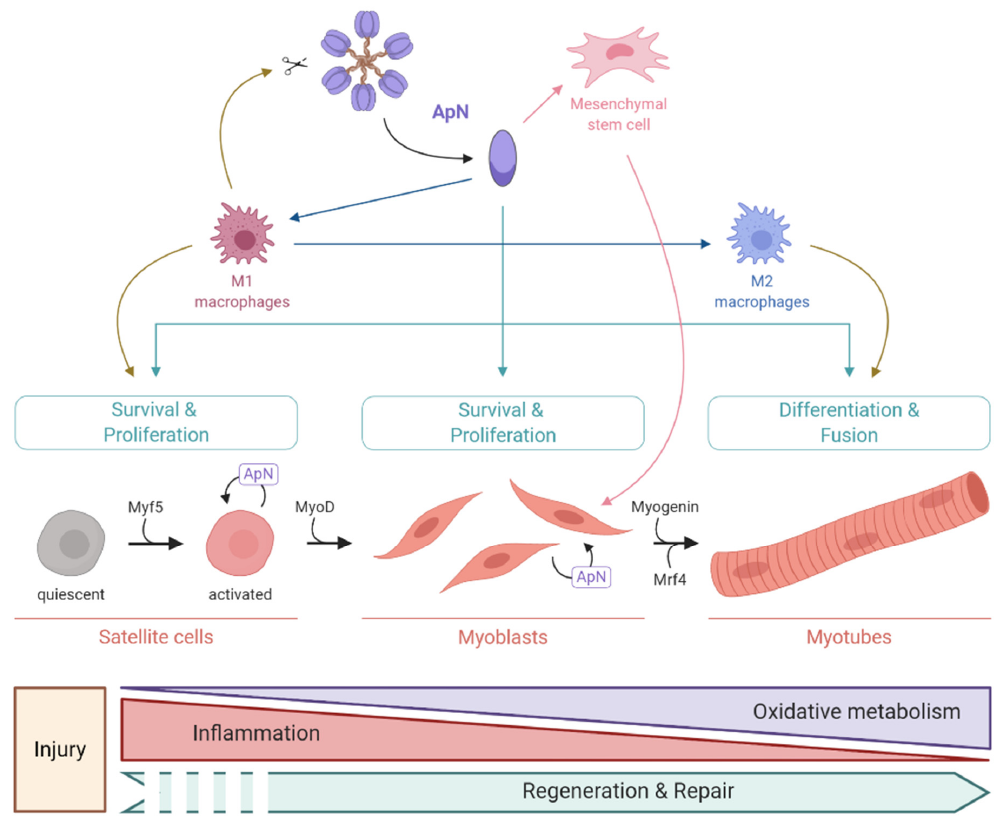
Figure 3. Pro-myogenic properties of ApN. This figure summarizes the multiple beneficial e ff ects of ApN on several steps of muscle regeneration (boxes in green), while highlighting an important interplay among 3 major processes, including resolution of inflammation, energy metabolism, and muscle repair. These pro-myogenic properties of ApN have only been tested on rodent skeletal muscle thus far. Green arrows represent the direct pro-myogenic e ff ects of ApN. Blue arrows represent an indirect pro-myogenic e ff ect of ApN by inducing a shift from pro-inflammatory M1 to anti-inflammatory M2 macrophages, for a resolution of inflammation and activation of the tissue-healing process. Pink arrows represent an indirect pro-myogenic e ff ect of ApN by stimulating non-muscle stem cells and driving their commitment towards the skeletal muscle lineage. Brown arrows represent the di ff erent e ff ects of macrophages. Created with BioRender.com.